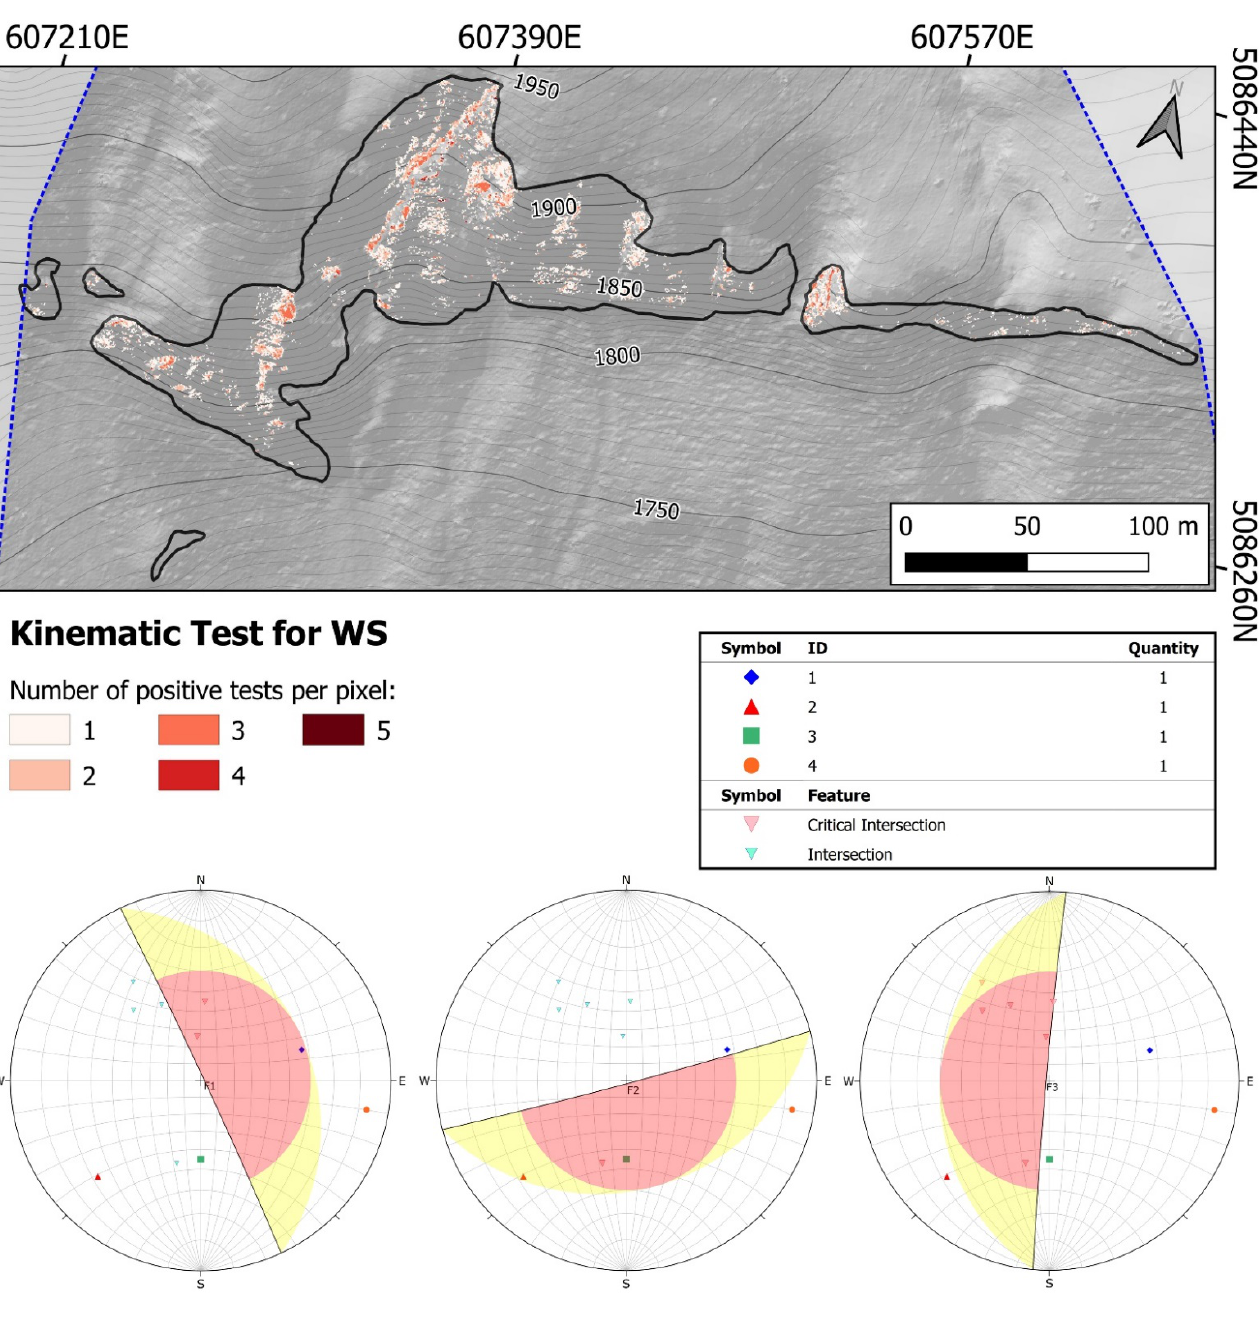
Figure 10. ( above ) Image of the WS sum matrix showing the pixels where the kinematic test for WS is positive: in this case, up to five intersections between the four joint sets can be active at the same time; ( below ) the three traditional stereoplot kinematic tests for WS on the F1 to F3 slope configurations: there is always at least on intersection active, but five are active at the same time on F3.